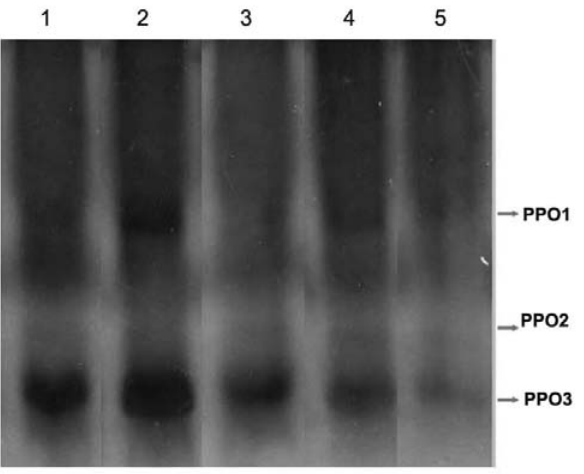
Fig. 4. Native PAGE profile of polyphenol oxidase (PPO) induced in response to challenge-inoculation of Pseudoperonospora cubensis in cucumber. Lane 1, Azoxystrobin; lane 2, Pseudomonas fl uorescens ; lane 3, mancozeb; lane 4, control (with inoculation); lane 5, control (no inoculation).